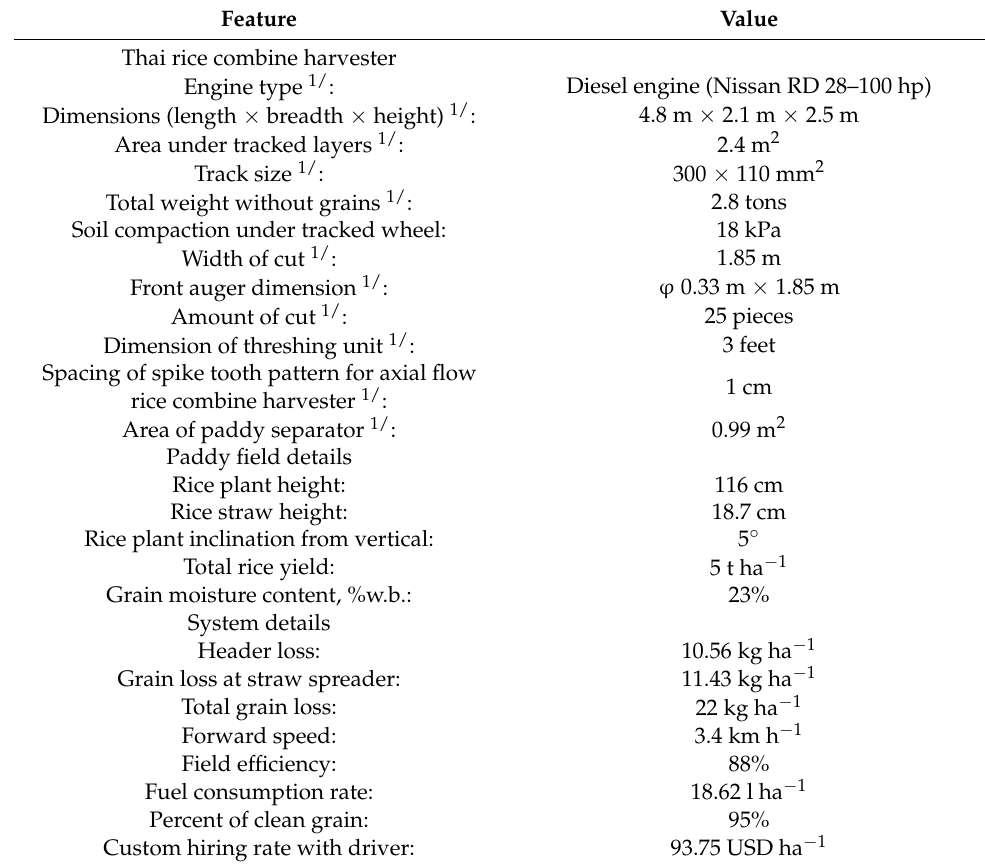
Table 1. Details of experimental setup and vital field